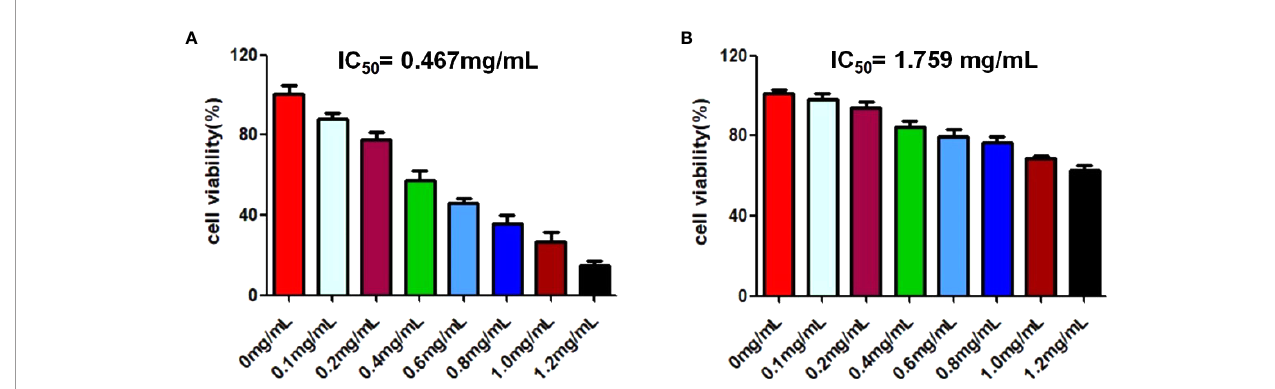
FIGURE 7 | Cytotoxic effects of RPL on A549 cells (A) and HUVEC cells (B) . Cells were treated with RPL (0, 0.75, 1.5, 3.0, 6.0, 12, and 24 µg/mL) for 24 h. Finally, CCK-8 assays were carried out to detect the cytotoxic effects of candidate drugs. The IC 50 values were calculated for evauation of the cytotoxic effects of candidate